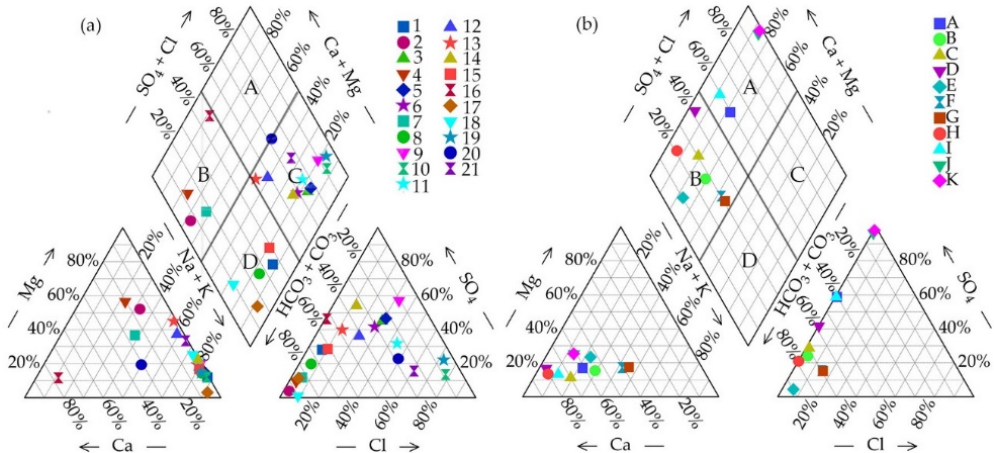
Figure 2. Piper diagram showing major ion concentration of the tectonic lakes ( a ) and glacial lakes ( b ).